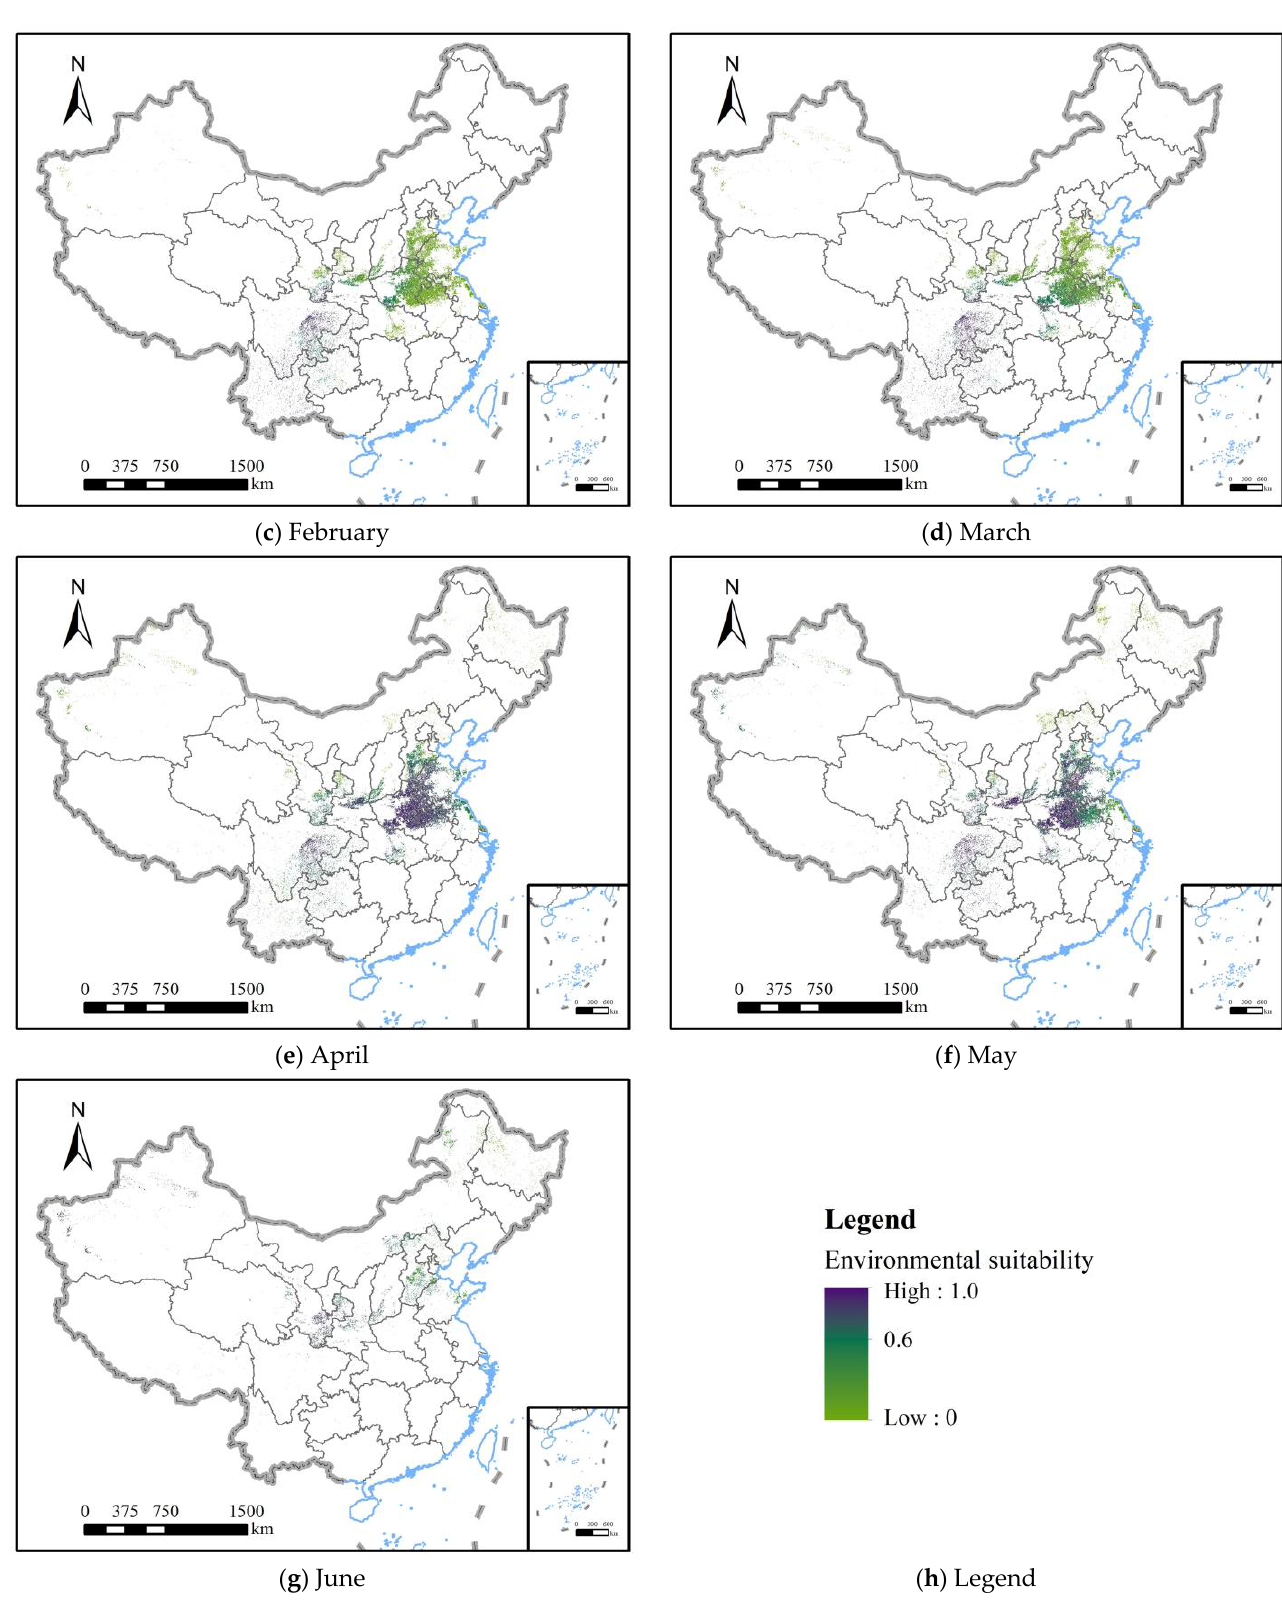
Figure 5. Environmental suitability of stripe rust from December to June in wheat-planting areas.